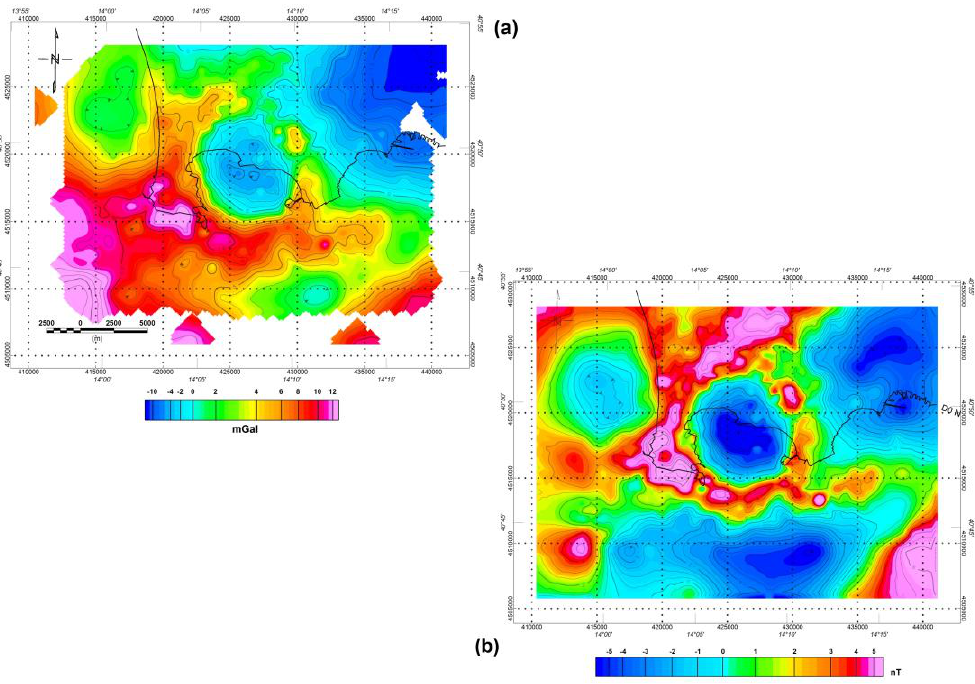
Figure 6. The CBA ( a ) and the regional de-trended CBA ( b ) maps of the Phlegraean